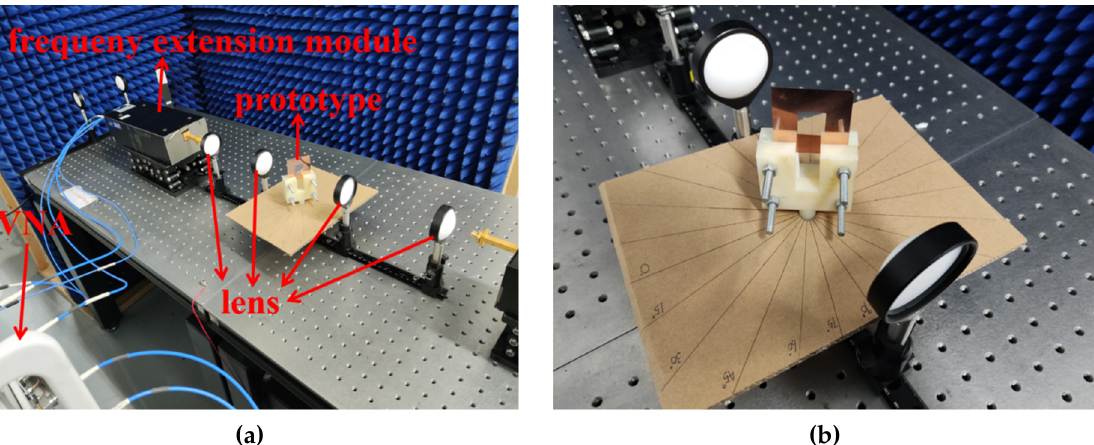
Figure 8. ( a ) Free space measure setup used for measurement of the proposed FSS. ( b ) Arrangement of prototype for measurement under different angles.